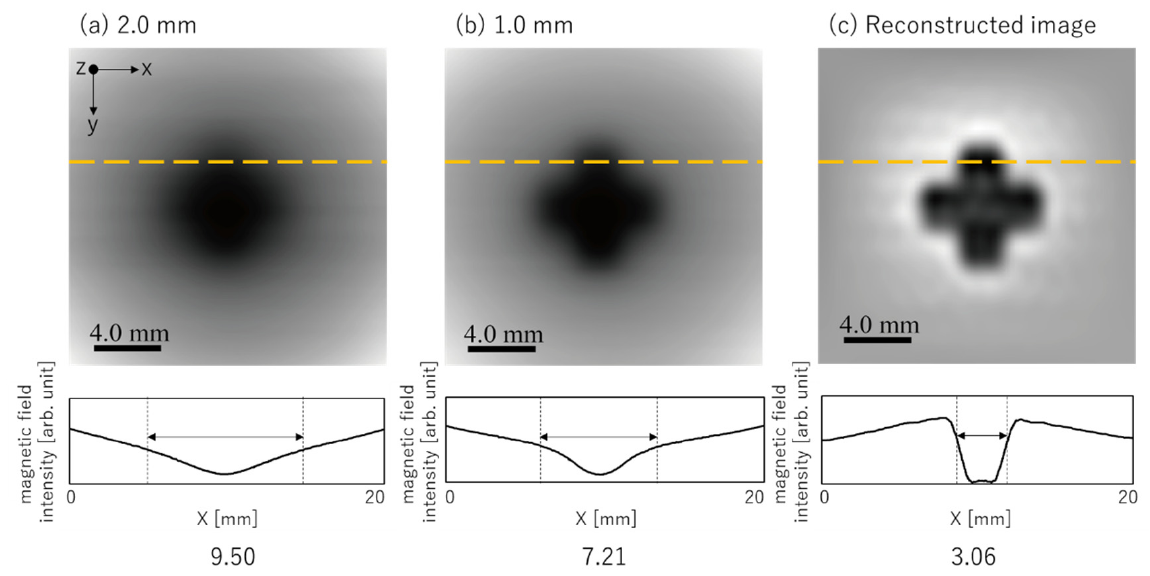
Figure 4. Two-dimensional magnetic particle distributions: I images and magnetic field intensity profiles measured at 1.7 mm ( a ) and 1.5 mm ( b ) distances from the magnetic source, and reconstruction I ( c ) based on Images I ( a ) and I ( b ).